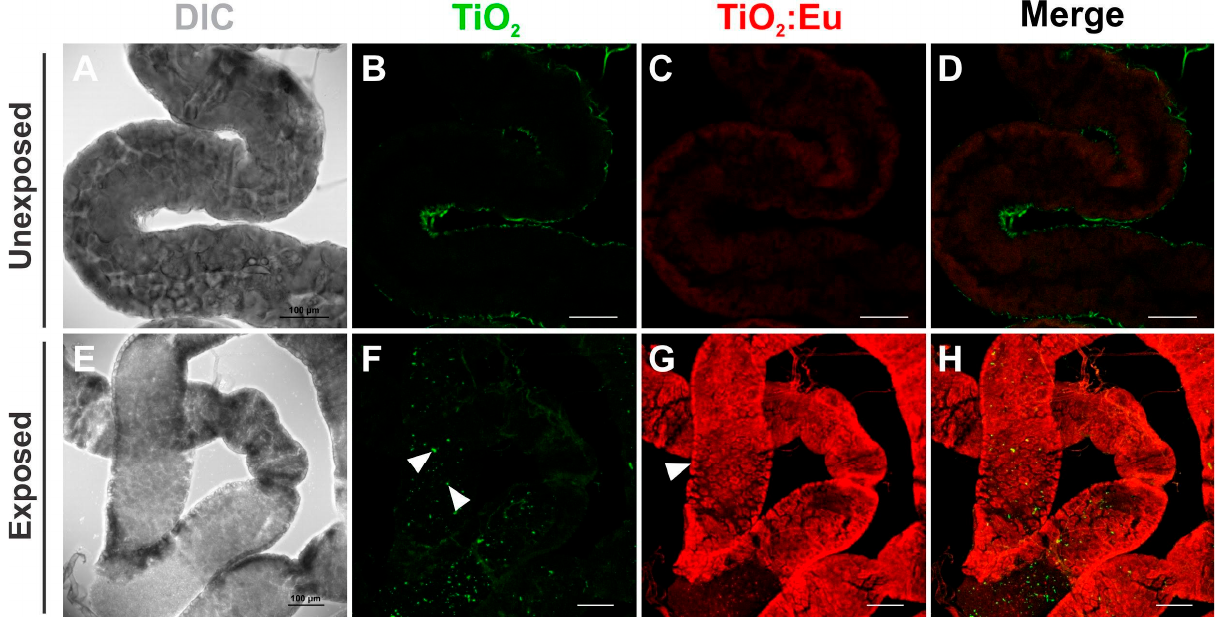
Figure 5. Confocal images of the distribution of TiO 2 and Eu 3+ -doped TiO 2 nanocrystals in the Drosophila adult gut. ( A – D ) Gut dissected from unexposed flies fed in standard food medium showing a poor signal of autofluorescence of the food. (( E – H ) Gut dissected from adult flies developed in 4 mg/mL of TiO 2 and Eu 3+ -doped TiO 2 showed these nanocrystals dispersed along the lumen (arrowheads in ( F )). Eu 3+ -doped TiO 2 nanocrystals have also been found in the cytoplasm of the cells that form the wall of the gut (arrowhead in ( G )). DIC: differential interference contrast; Green: TiO 2 nanocrystals fluorescence under 405 nm laser excitation; Red: Eu 3+ -doped TiO 2 nanocrystals fluorescence under 552 nm laser excitation. Scale bars = 100 μ m.